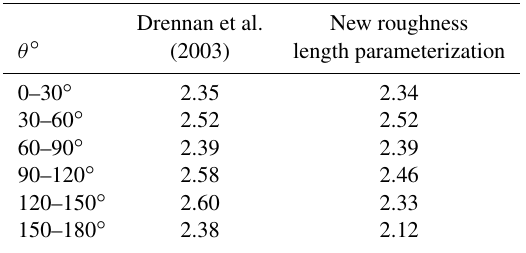
Table 4. Root mean square error for six different alignment classes and for two different roughness length parameterizations: Drennan et al. (2003) and the newly proposed roughness length parameteri-